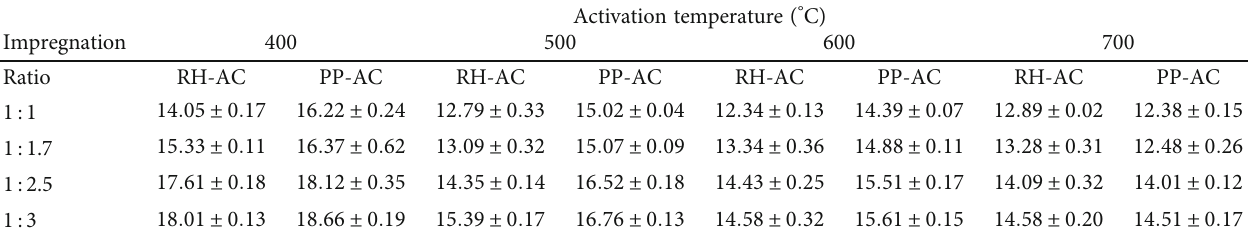
Table 2: The volatile matter in the prepared activated carbon samples.